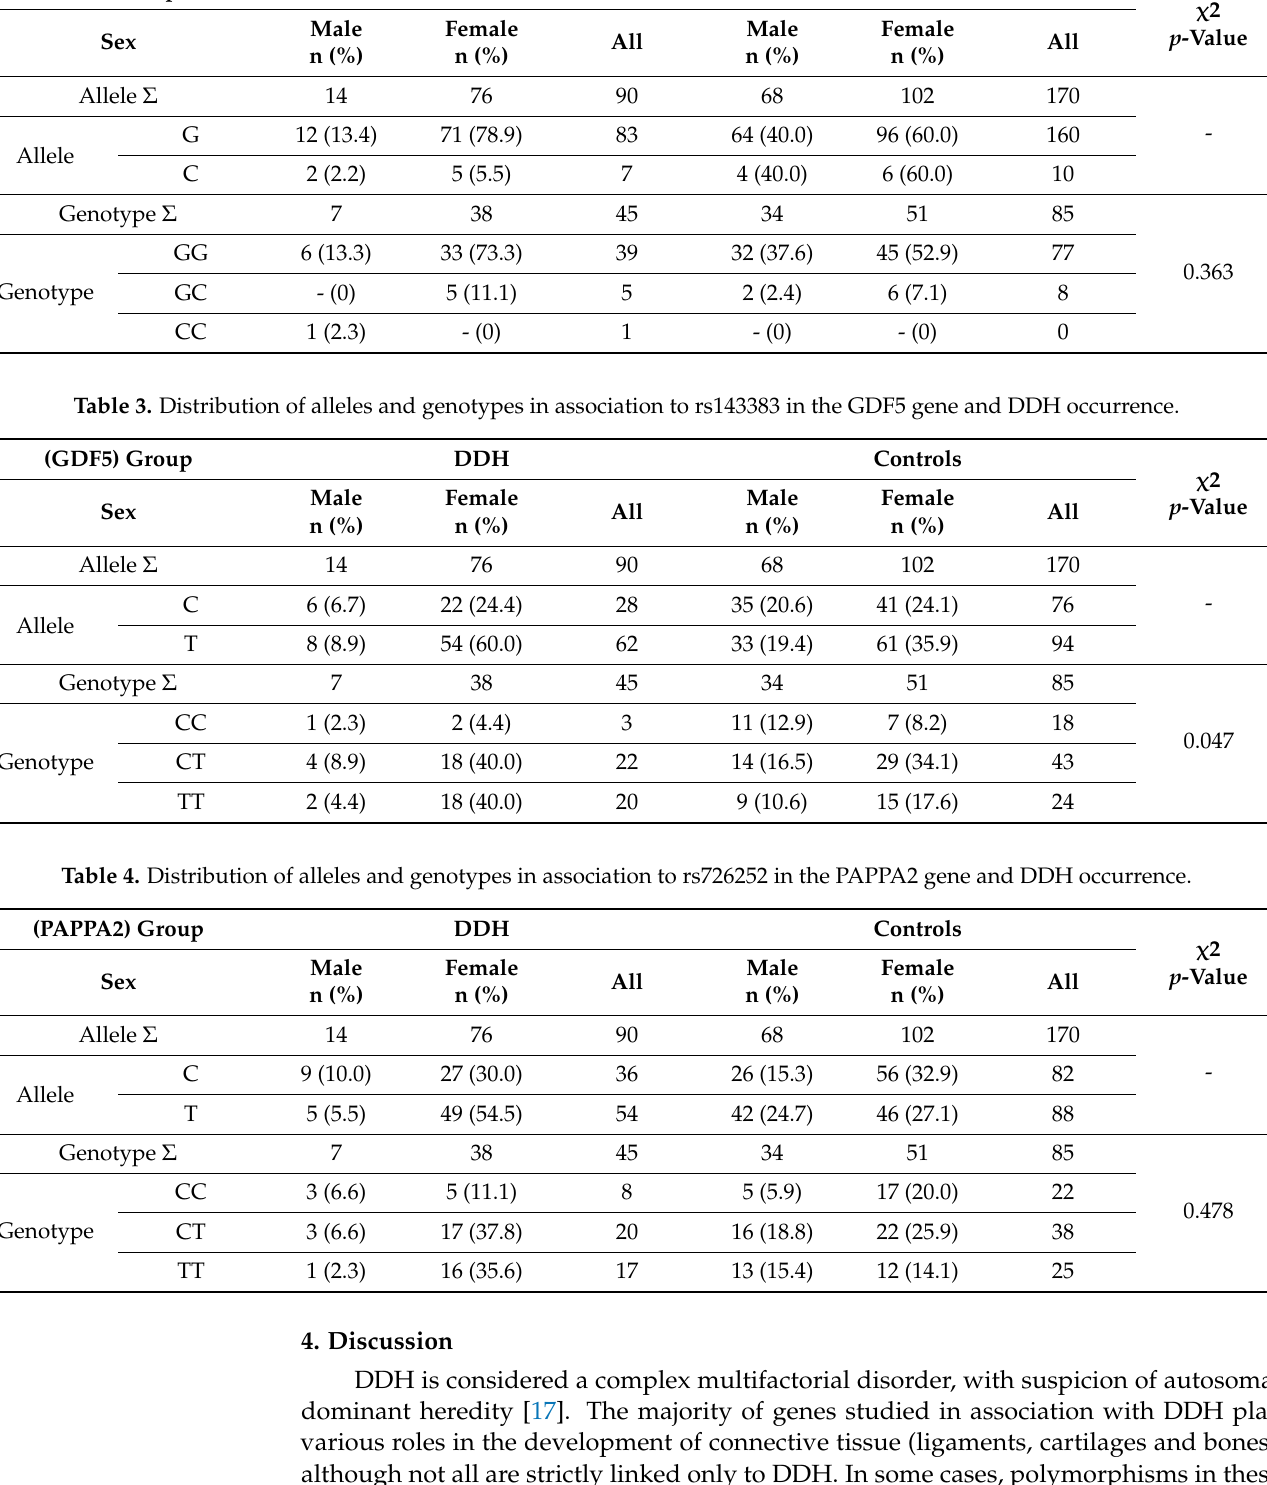
Table 2. Distribution of alleles and genotypes in association to rs1800796 in the IL6 gene and DDH occurrence. (IL6) Group